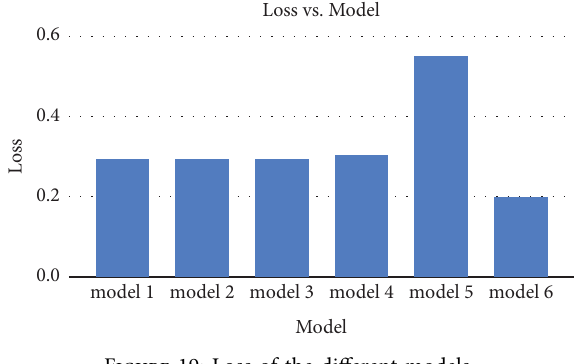
Figure 19: Loss of the diferent